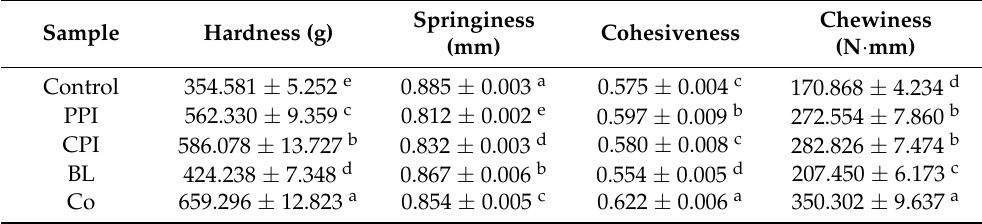
Table 4. Effects of different protein pre-emulsified soybean oil on the fish-sausage texture.